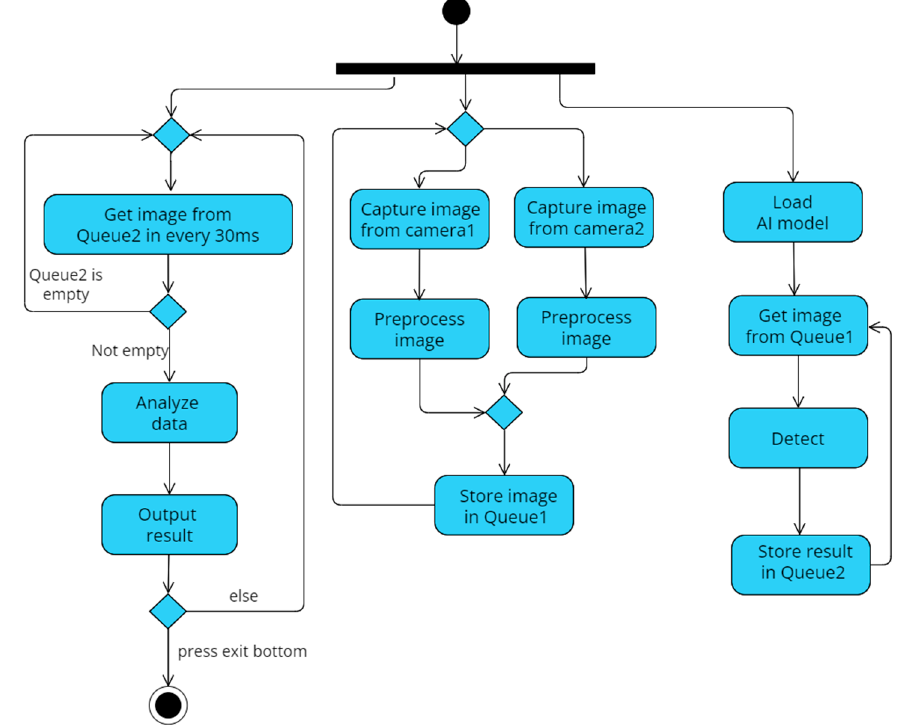
Figure 2. Software activity diagram.